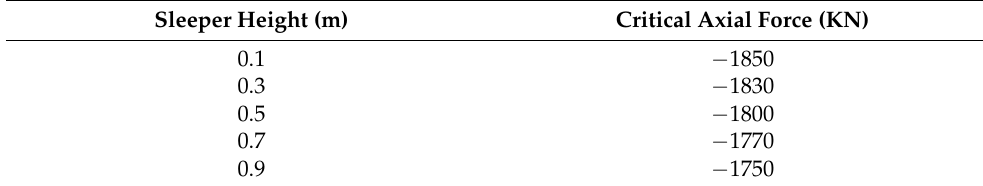
Figure 9. Influence of sleeper height in the axial force–lateral displacement graph. Table 7. Critical axial force of sleeper height.